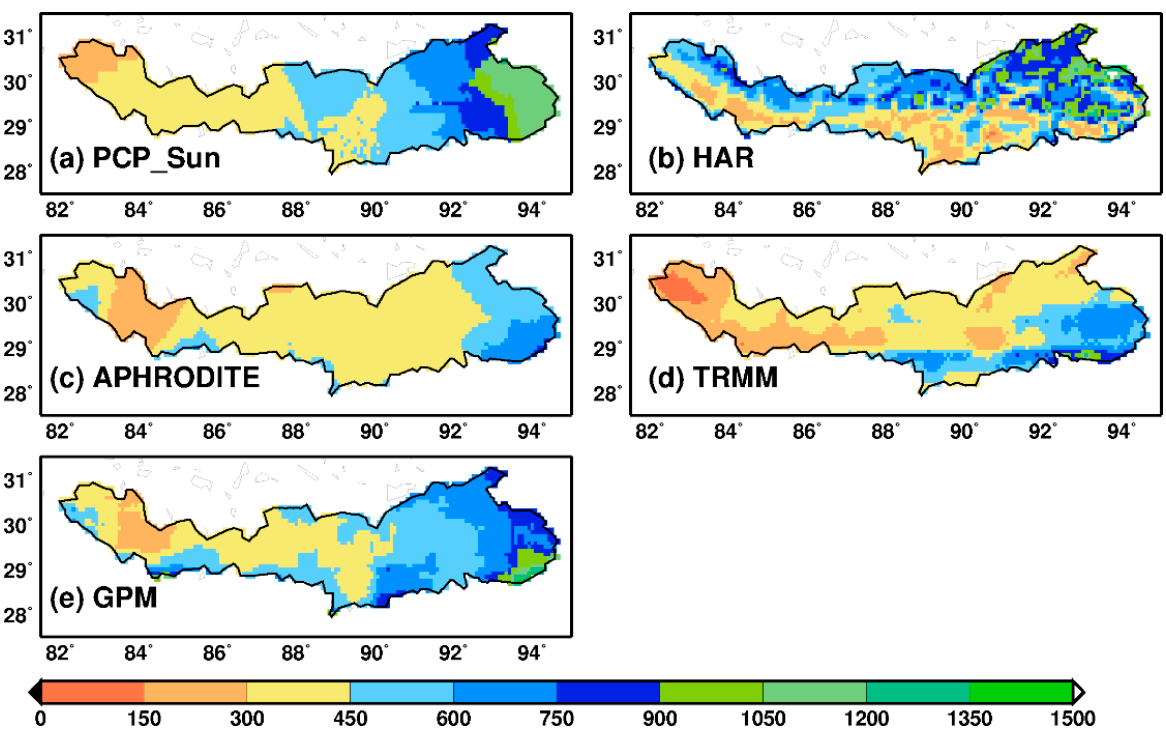
Figure 2. Spatial distributions of annual mean precipitation for reference precipitation (PCP_Sun) and four gridded precipitation datasets among 2001–2013 over the UB (mm/year).